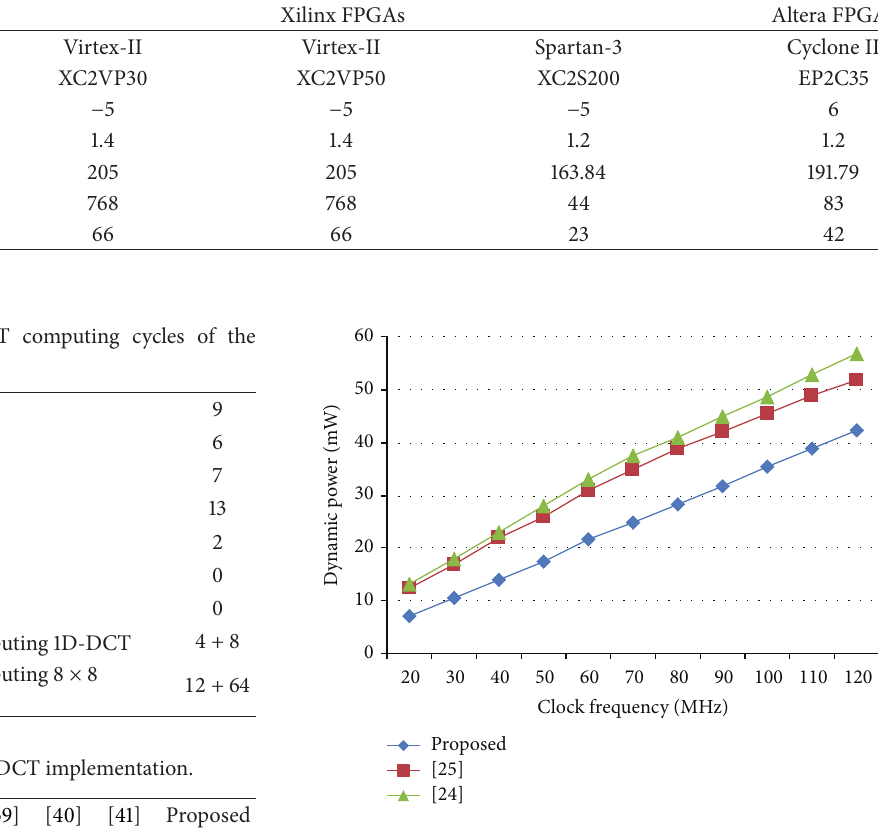
Figure 3: Dynamic power consumption estimation per sample